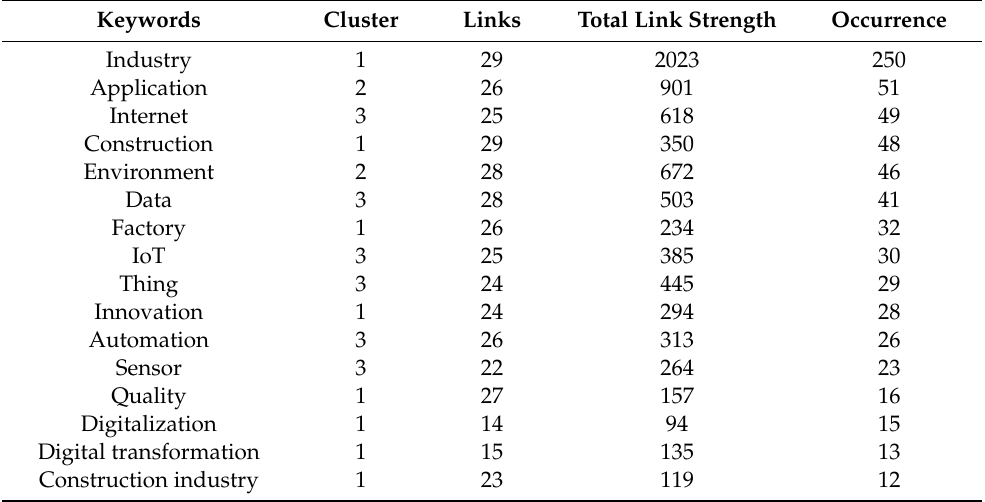
Table 6. Most commonly co-occurring keywords of “Industry 4.0” OR “Industrial revolution 4.0” AND TOPIC “construction” OR “building” in Scopus.